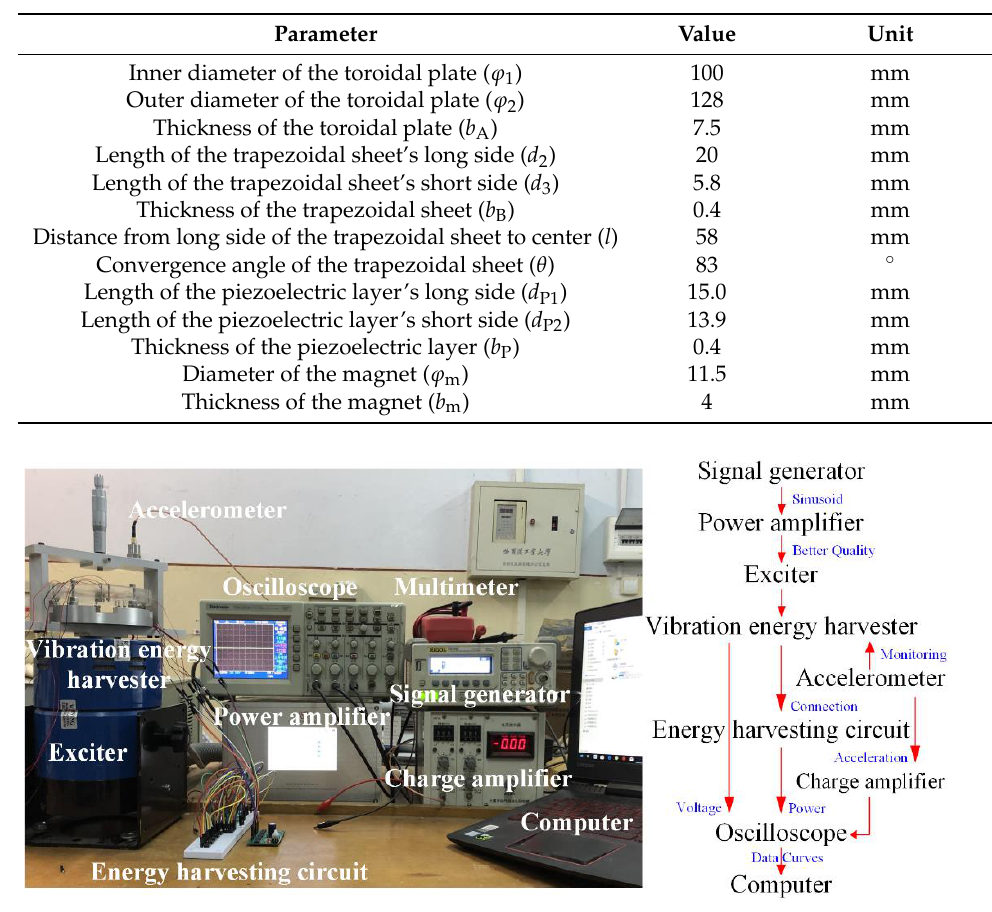
( d ) Figure 3. Schematic diagram of the SPEH model and colored pattern. ( a ) Fixed beam simplified model (cross-section of SPEH vibrator). ( b ) Fixed beam simplified model (single trapezoidal beam of SPEH vibrator). ( c ) Colored pattern of stress. ( d ) Colored pattern of displacement under external force. The “five -end fixed and central mass shared” model (shown in Figure 1a) can be sim- plified to a fixed beam clamped on both ends, approximated to a linear system under the premise of small deformation, as shown in Figure 1b. The deflection w at point C of the cantilever beam is: